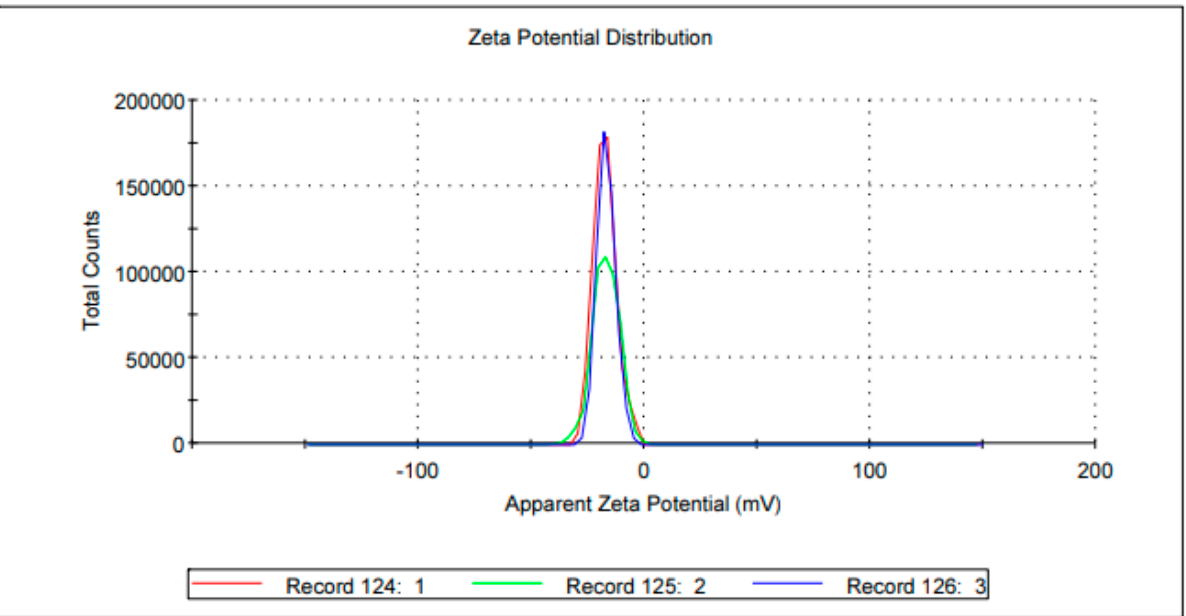
Figure 2. Average size of AgNPs prepared with aqueous A. nilotica pod extract.